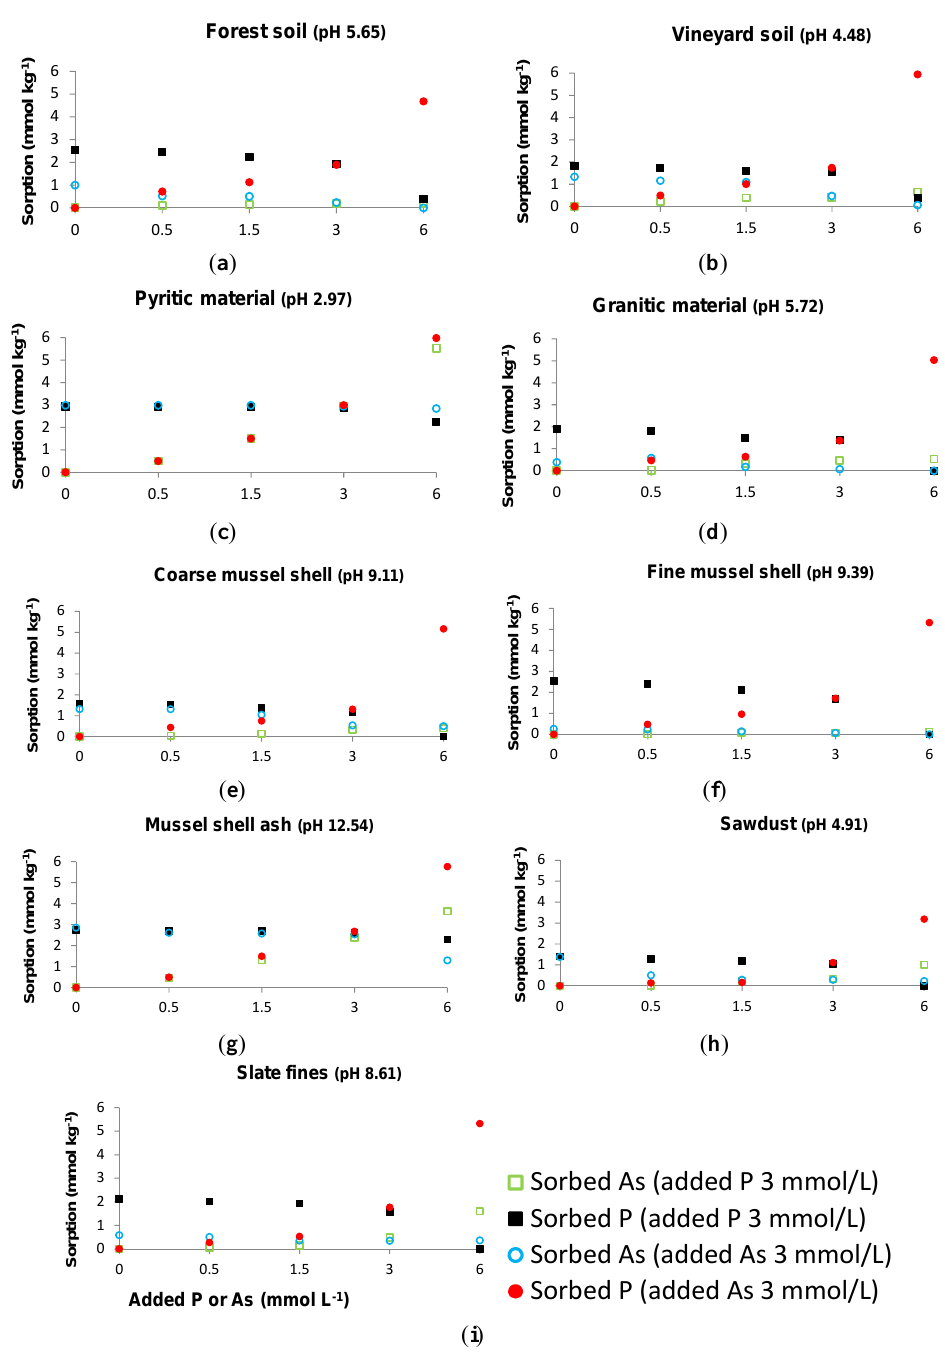
Figure 1. Sorbed As (empty green squares) and sorbed P (filled black squares) when added P is 3 mmol·L − 1 and added As is increased from 0 to 6 mmol·L − 1 . Sorbed As (empty blue circles) and sorbed P (filled red circles) when added As is 3 mmol·L − 1 and added P is increased from 0 to 6 mmol·L − 1 . ( a ) forest soil; ( b ) vineyard soil; ( c ) pyritic material; ( d ) granitic material; ( e ) coarse shell; ( f ) fine shell; ( g ) shell ash; ( h ) pine-sawdust; ( i ) slate fines.